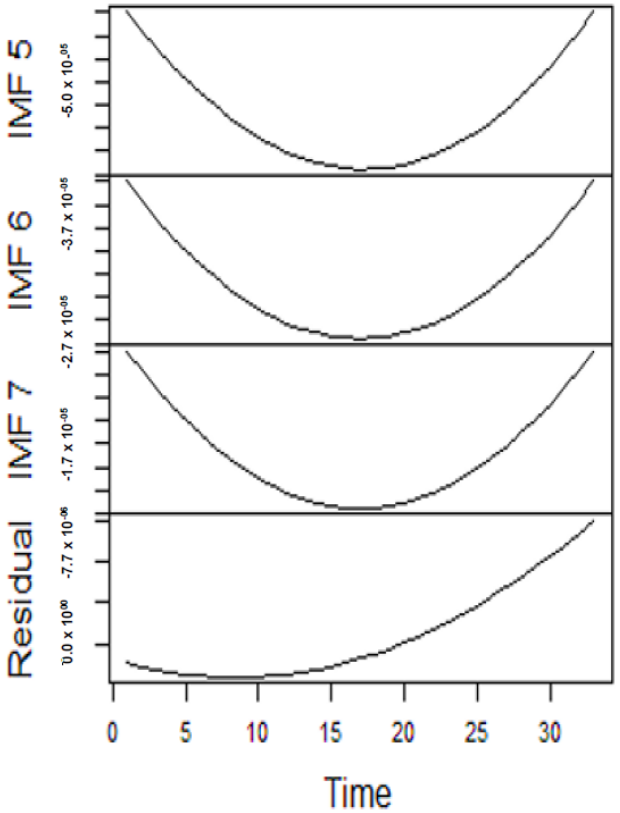
Figure 10. Panel B: The remaining IMFs for Japan gas prices in normal times.